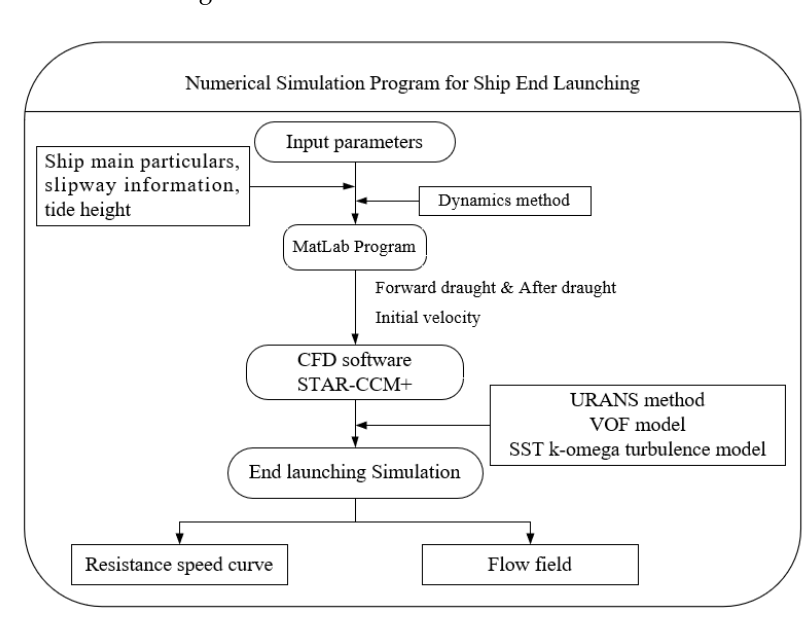
Figure 2. Overview of methodology for the ship’s longitudinal launching.